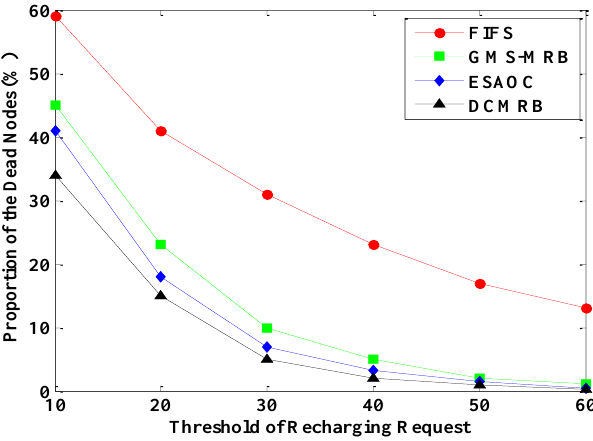
Figure 27. Proportion of the dead nodes under different recharging thresholds.